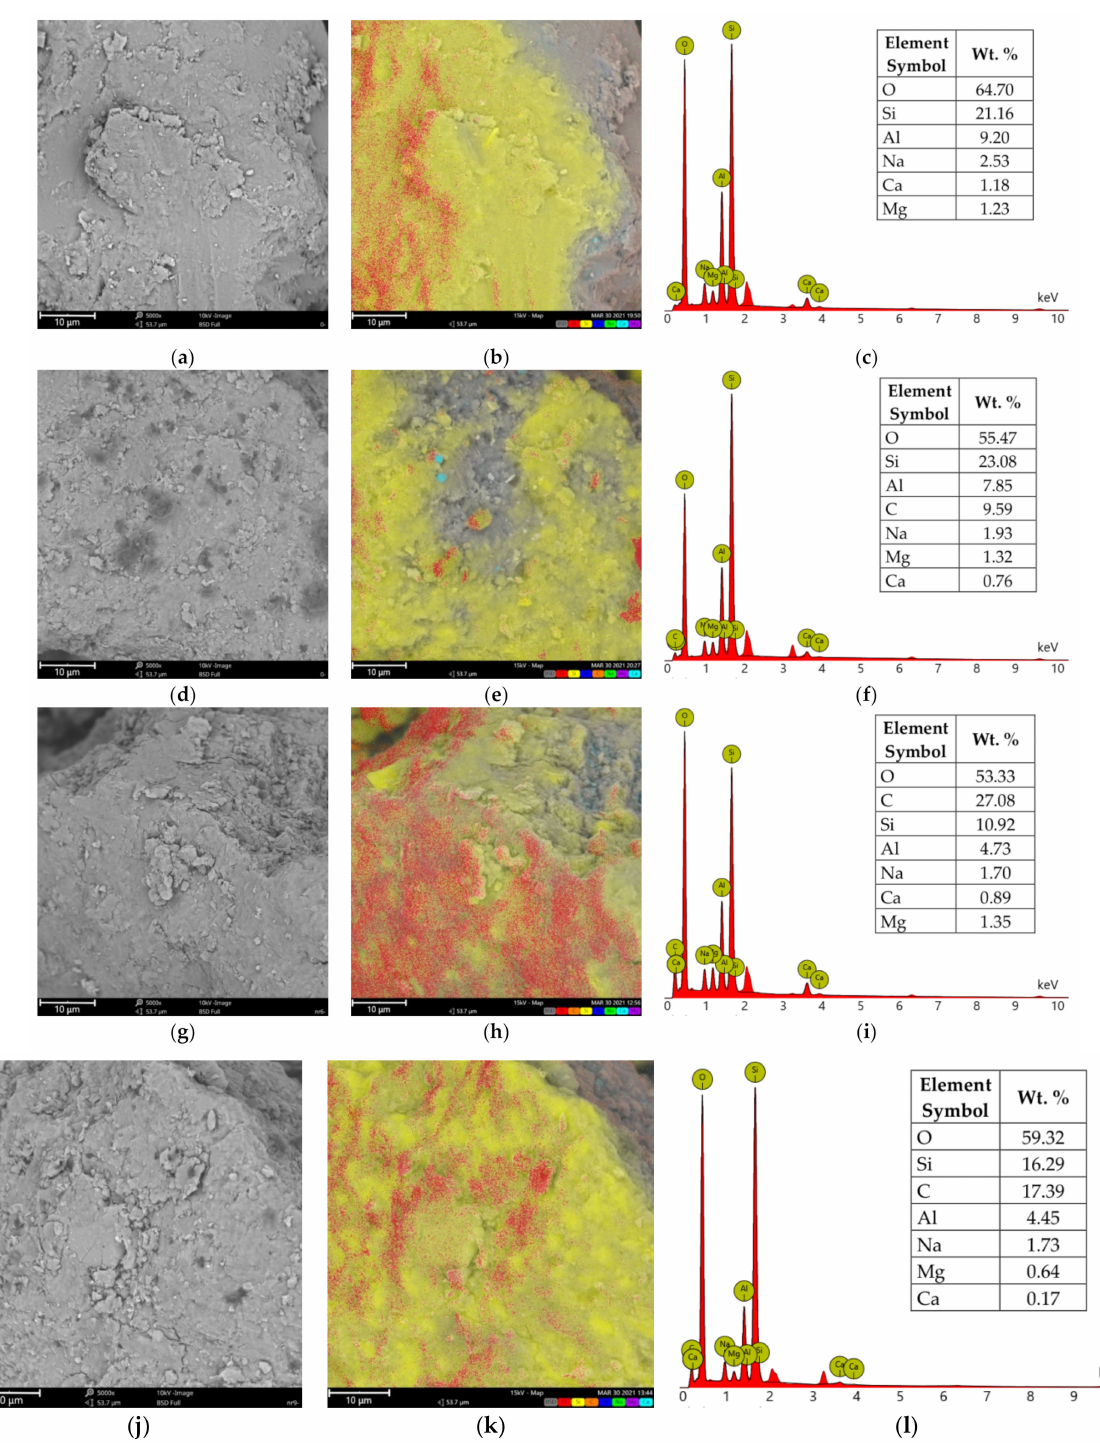
Figure 12. SEM images of ( a ) SN, ( d ) SN/25PAA, ( g ) SN/25PAA/Na, ( j ) SN-Na/25PAA materials, respectively; elemental distribution of ( b ) SN, ( e ) SN/25PAA, ( h ) SN/25PAA/Na, ( k ) SN-Na/25PAA materials, respectively (element color: O—red, Si—yellow, Al—dark blue, C—orange, Na—green, Mg—purple, Ca—light blue); EDS analysis of ( c ) SN, ( f ) SN/25PAA, ( i ) SN/25PAA/Na, ( l ) SN-Na/25PAA materials, respectively. The analysis was performed at a magnification of 5000 ×